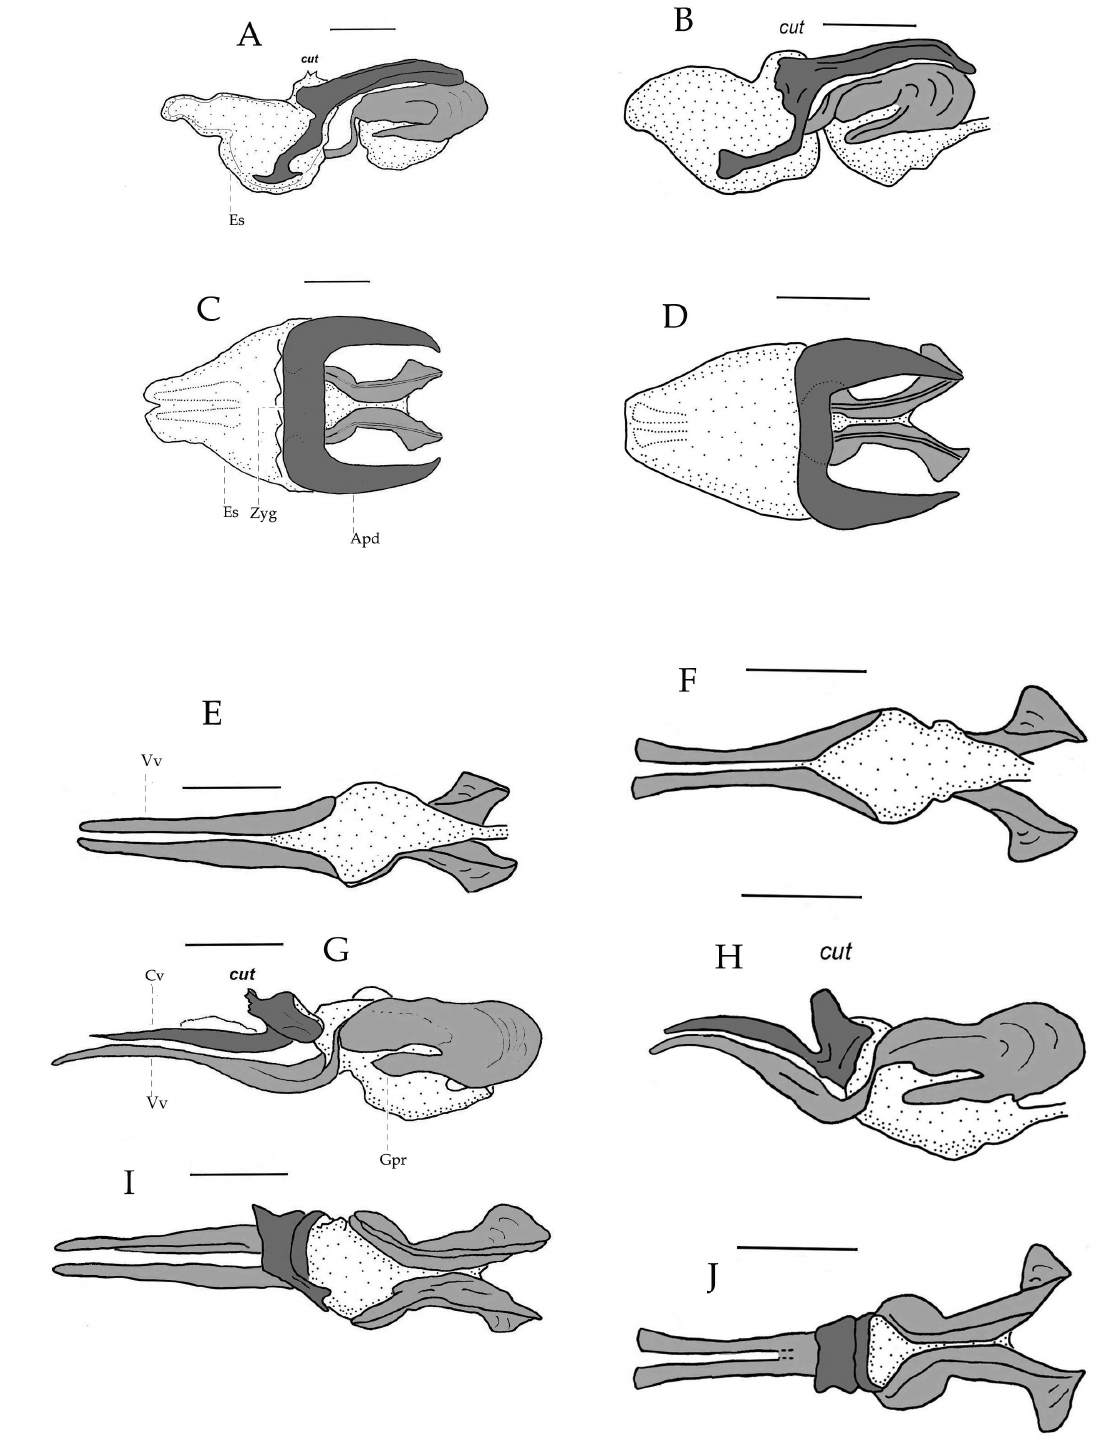
Fig. 7. Ectophallus and endophallus of Gemeneta spp. A, B. Entire phallic complex without epiphallus in lateral view; C, D. Entire phallic complex without epiphallus in dorsal view; E, F. Endophallus in ventral view; G, H. Endophallus in lateral view; I, J. En- dophallus in dorsal view; A, C, E, G, I. G. terrea and B, D, F, H, J. G. opilionoides ; Apodemes of cingulum (Apd): pair of ectophallic sclerotized structures situated dorsally to endophallus; Valves of cingulum (Cv): pair of valves projecting from the posterior end of the cingulum from the arch of cingulum; they form the upper valves of the aedeagus; Ectophallic sheath (Es): the membrane part of ectophallus covering the ventral aedeagal valves and valves of cingulum, often partially sclerotized; Gonopore processes (Gpr): pair of ventral processes from the aedeagal valves, functioning as a pinch valve between the ejaculatory and spermatophore sacs; Ventral aedeagal valves (Vv): endophallic valves, divided in two parts; Zygoma (Zyg): transverse dorsal part of cingulum, connecting the ap- odemes. Scale bars = 0.5